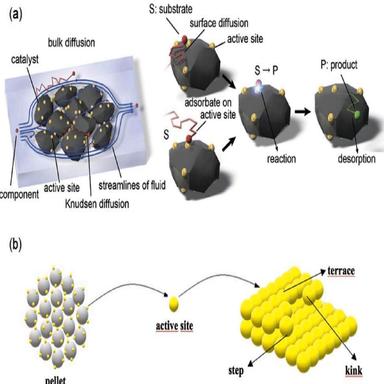
(a) Transport processes at catalyst pellets: S is substrate, P is product. (b) Structure of an organized catalyst pellet with active sites.